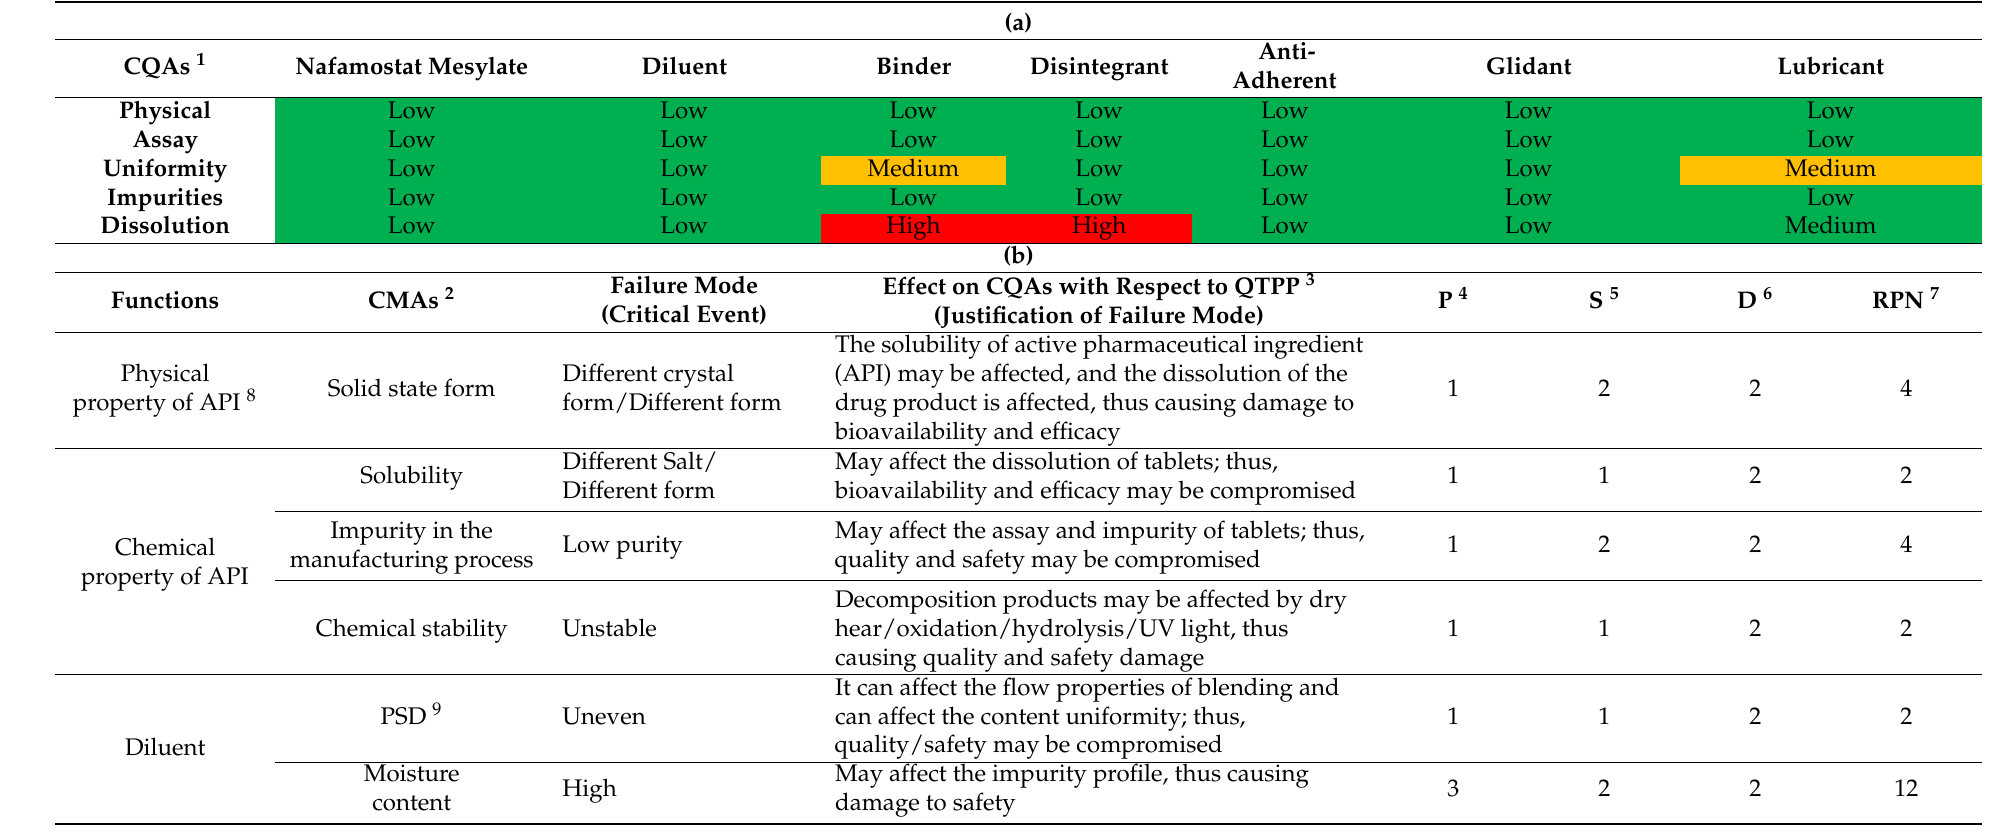
Table 5. (a) Qualitative preliminary hazard analysis (PHA) and (b) quantitative failure mode effects analysis (FMEA) of material attributes